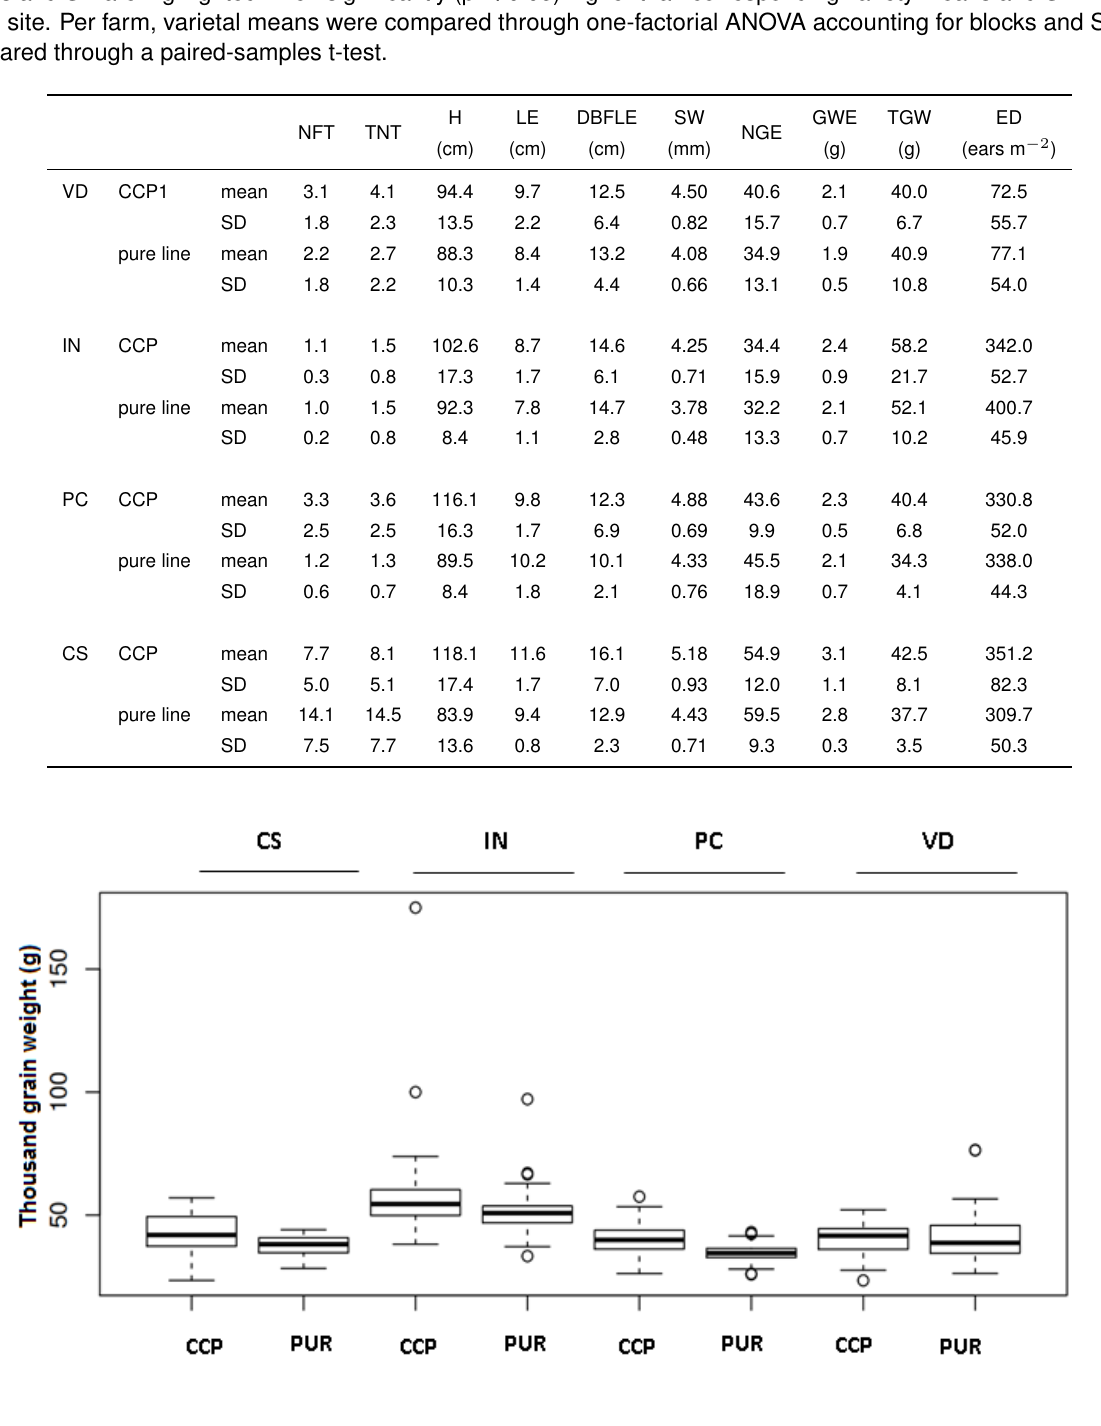
Figure 1. Box-plots of thousand grain weight for each site (CS, IN, PC and VD) and variety (CCP = Composite Cross Population, PUR = Pure